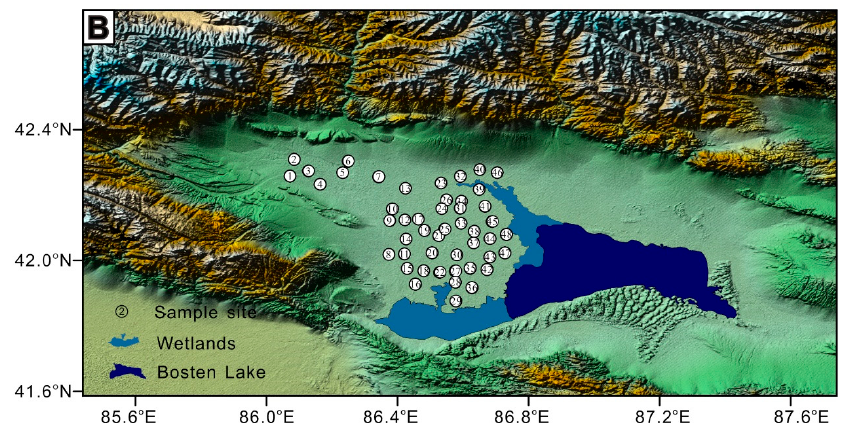
Figure 1. The geographical location of the Bosten Lake region ( A ) and the sampling sites ( B ).